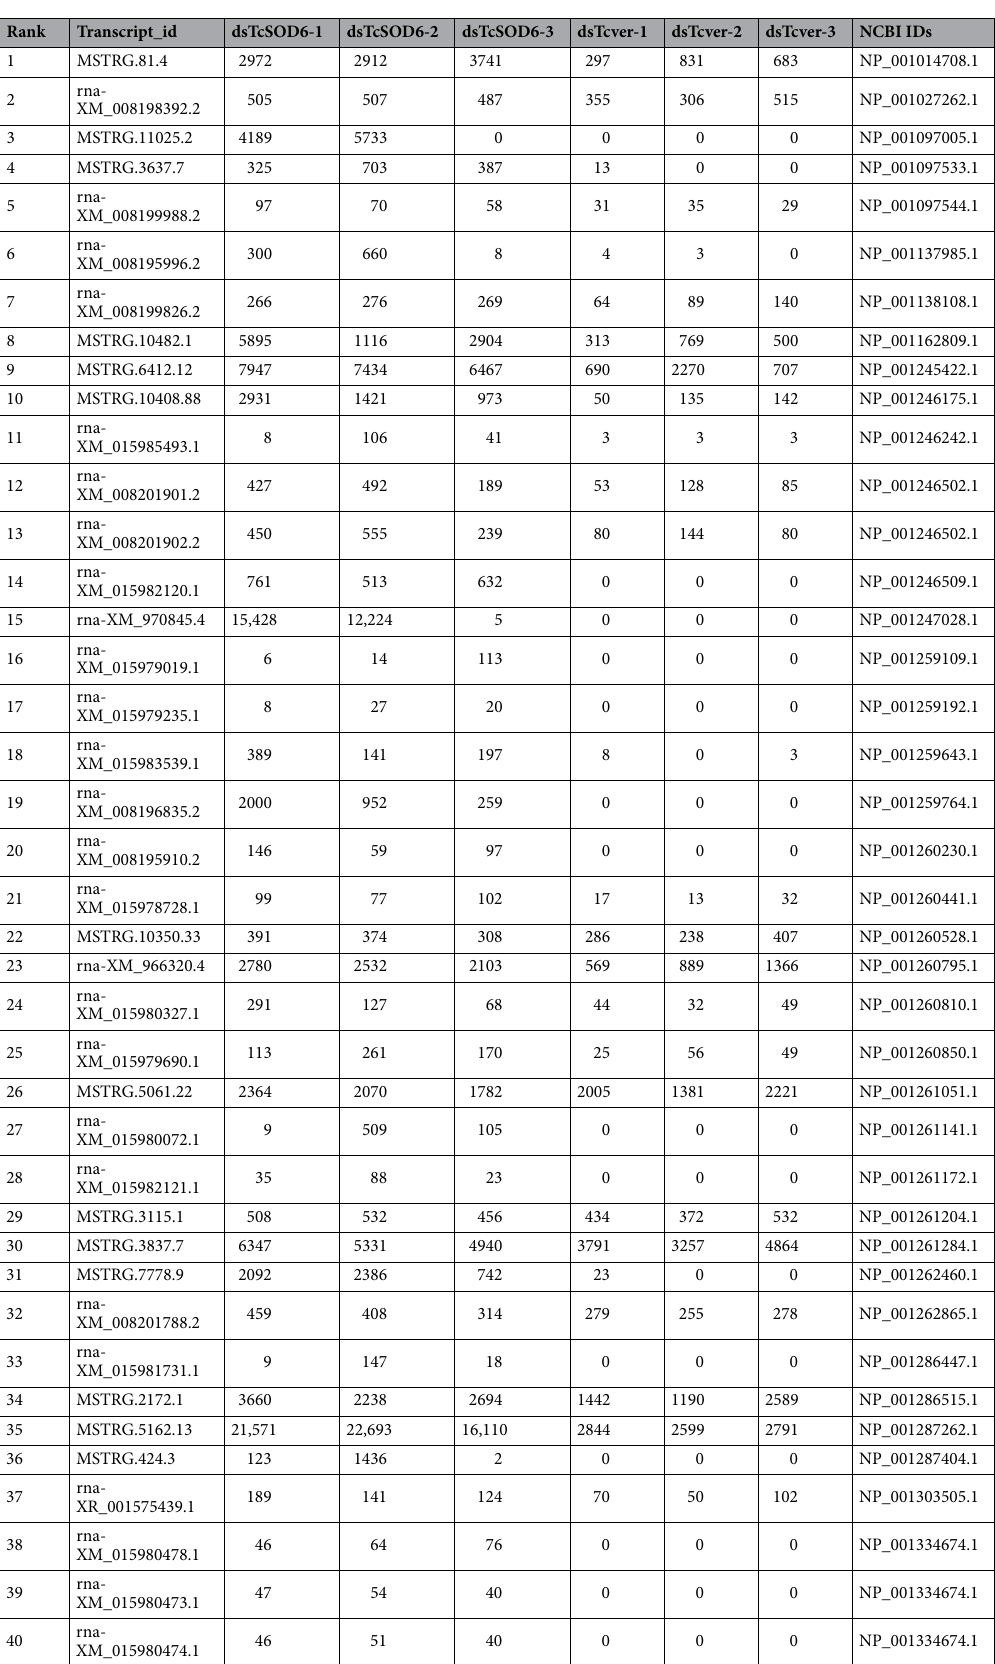
Table 1. The count data for upregulated transcripts in the TcSOD6 -knockdown groups. These count data indicate the number of sequence fragments that have been assigned to each gene. (n = 3, biological